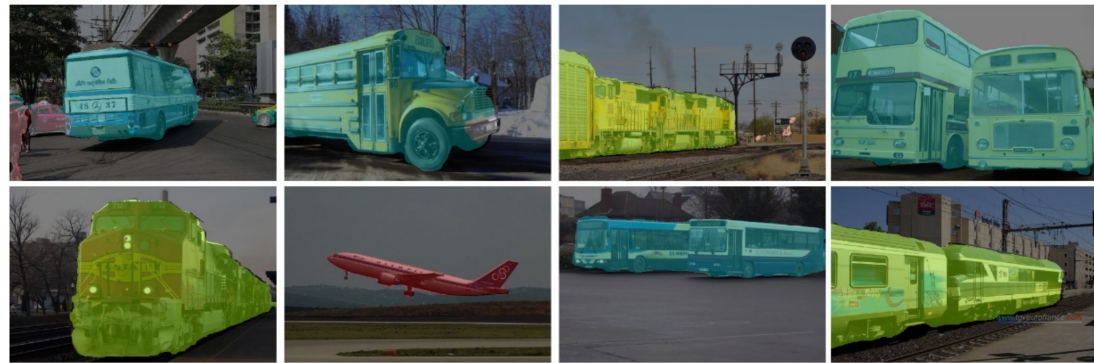
Figure 10. Segmentation results on PASCAL VOC 2012